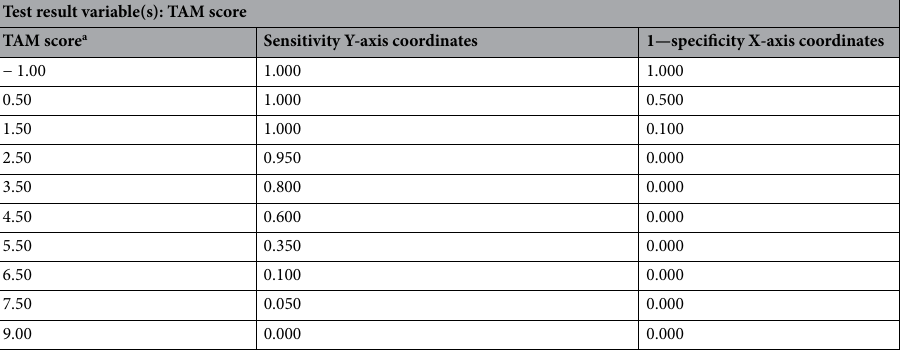
Table 4. Sensitivity and 1-specificity values at different AMS, calculated based on the ROC curve (Coordinates of the curve) in B-B kinship analysis by autosomal STR. The smallest TAM score cutoff value is the minimum observed test value minus 1, and the most considerable cutoff value is the maximum perceived test value plus 1. All the other cutoff values are the averages of two consecutive ordered observed test